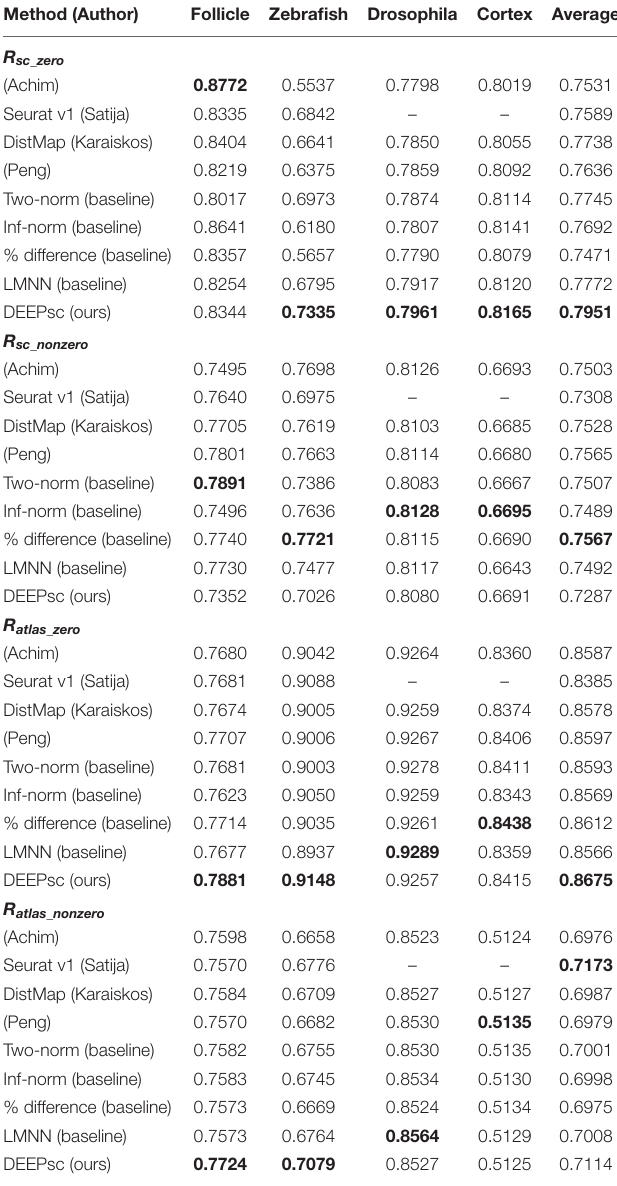
TABLE 2 | Predictive reproducibility of each method for real scRNA-seq data. Method